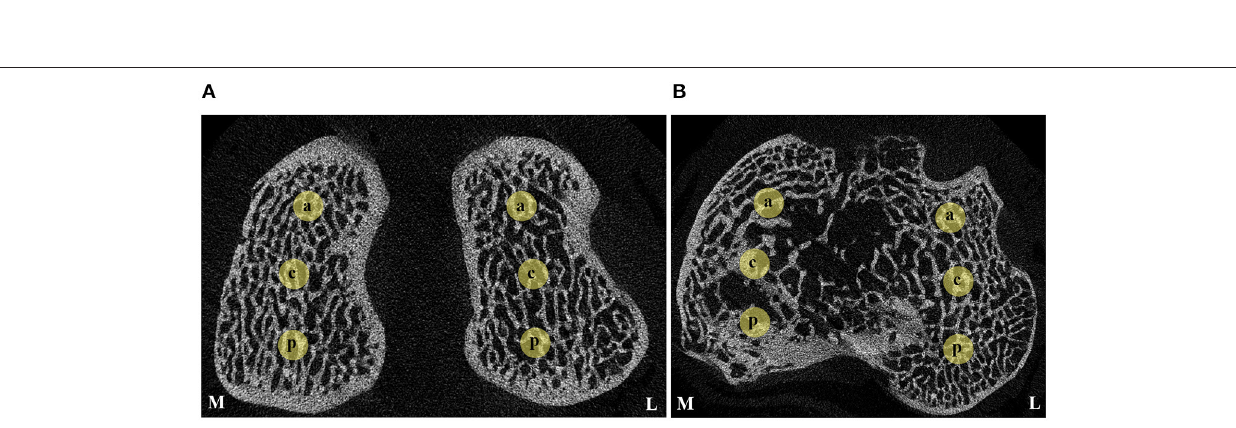
Frontiers in Veterinary Science |